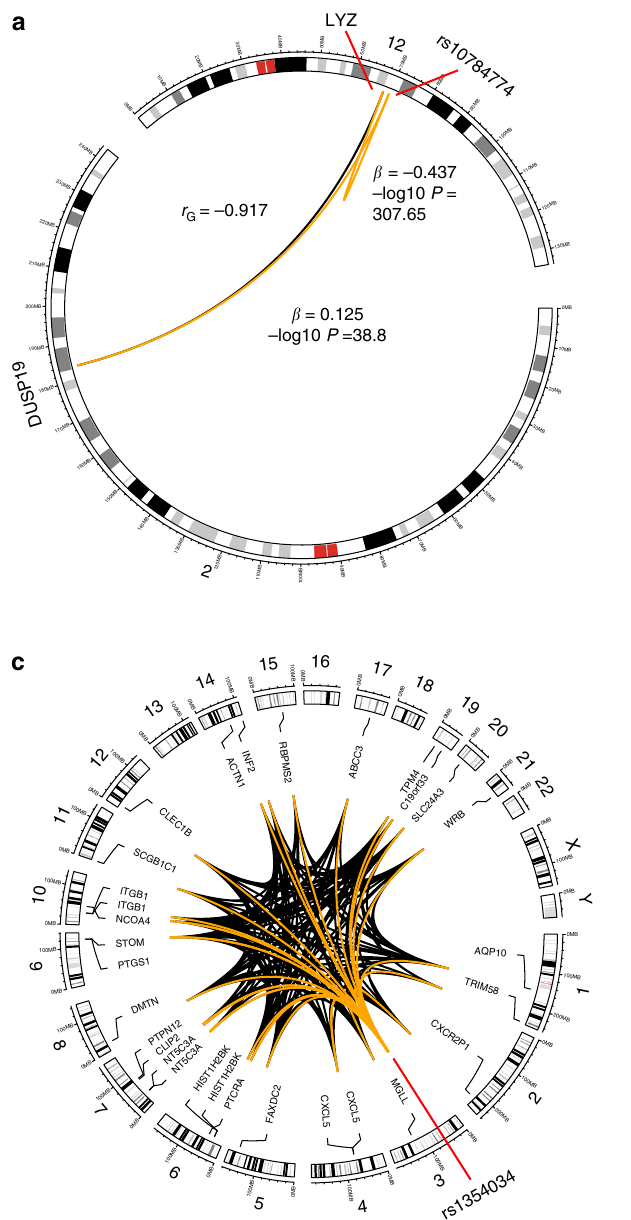
Fig. 2 The genome-wide effects of shared eSNPs (LIFE-Heart) on genetically correlated transcript pairs. a ( cis/trans ) shows a transcript pair located on different chromosomes ( trans ) with a strong negative ^ r G , where the expression of both transcripts is altered by a shared eSNP that is located on the same chromosome as one of the transcripts. DUSP19 (chr 2) and LYZ (chr 12) are both regulated by a shared eSNP (rs10784774; orange lines ), one in cis and one in trans , and have a negative ^ r G ( − 0.917; black line) that indicates an opposite allelic direction of effect, con fi rmed by the β values. The eSNP is on the same chromosome as one transcript ( cis ). b ( trans/trans ) depicts the effects of a shared eSNP (rs7980008) that is located on a different chromosome to each of the two transcripts CD79A and OSBPL10 , also located on separate chromosomes (19 and 3, respectively). The positive ^ r G between CD79A and OSBPL10 (0.911) indicates their shared trans eSNP alters their expression in the same allelic direction, as shown by the β values. c reveals the extensive transcriptional control by a single master trans- eSNP (rs1354034), with shared effects, that alters the expression of 30 individually genetically correlated transcripts corresponding to 26 unique genes. These 26 unique genes comprise 183 unique ^ r G pairs. β is the effect size of the eSNP, with accompanying – log10-transformed p -value, on transcript expression from the LIFE-Heart Study data summary statistics for 651 of the 934 eSNP-probe pairs. At a Bonferroni signi fi cant threshold of 0.05/934 = 5.4×10 − 5 , 100% replicate in CAGE (Supplementary Data 4) with 100% matched allelic direction. The result of this replication is striking and demonstrates that trans- eQTL that are associated with multiple transcripts are more prevalent than previously thought. It is important to note that the majority of these trans- eQTL would not have been identi fi ed using traditional eQTL mapping strategies NATURE COMMUNICATIONS | 8: 483 | DOI: 10.1038/s41467-017-00473-z |